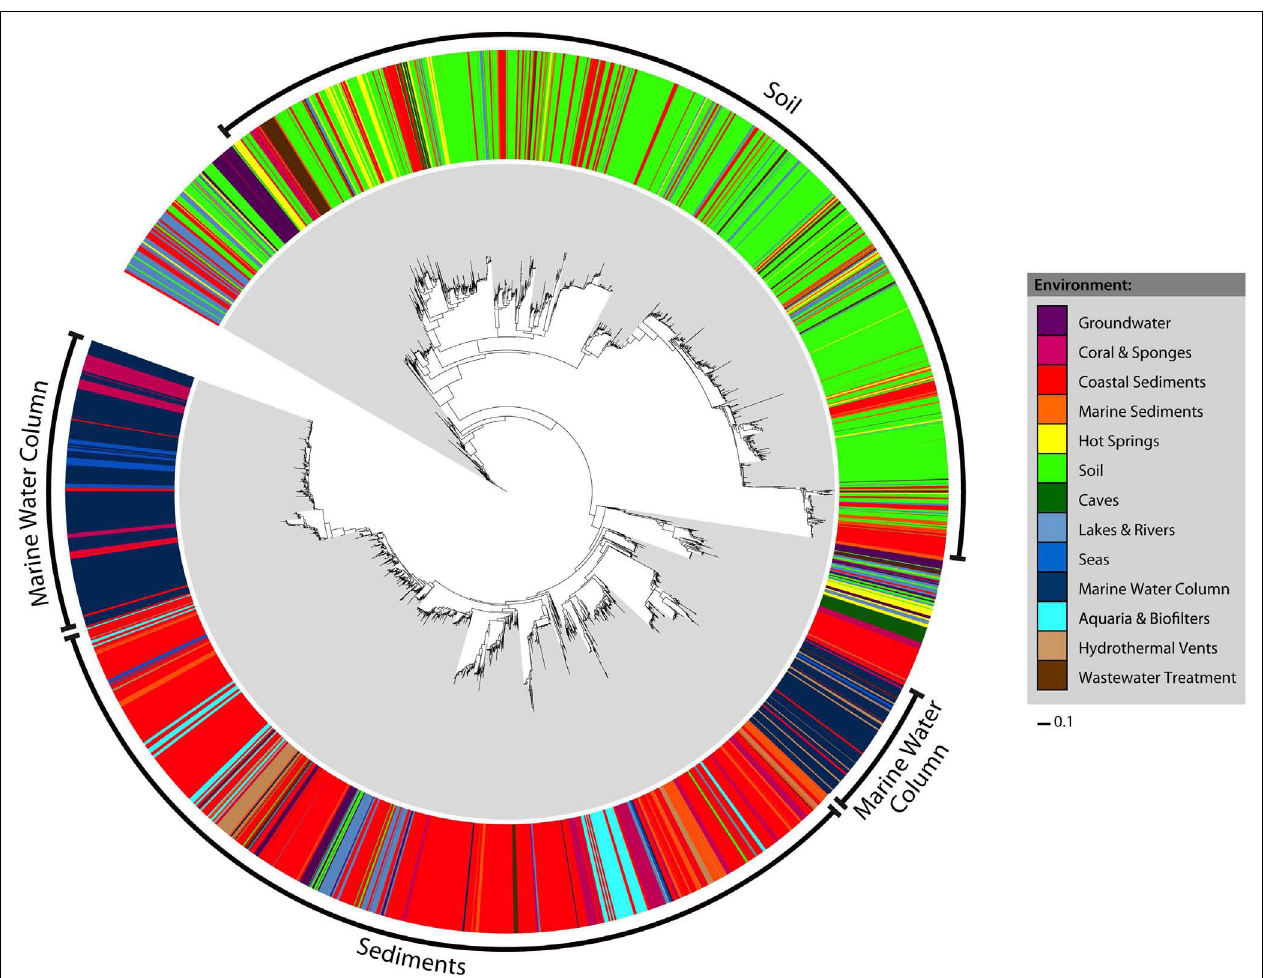
FIGURE 1 | Maximum likelihood phylogeny and habitat distribution among all 6203 uniqueAOA amoA sequences. Colored bars in the outer ring correspond to the habitat assignment for each individual sequence.The bacterial amoA out group has been excluded from the tree for visualization purposes.